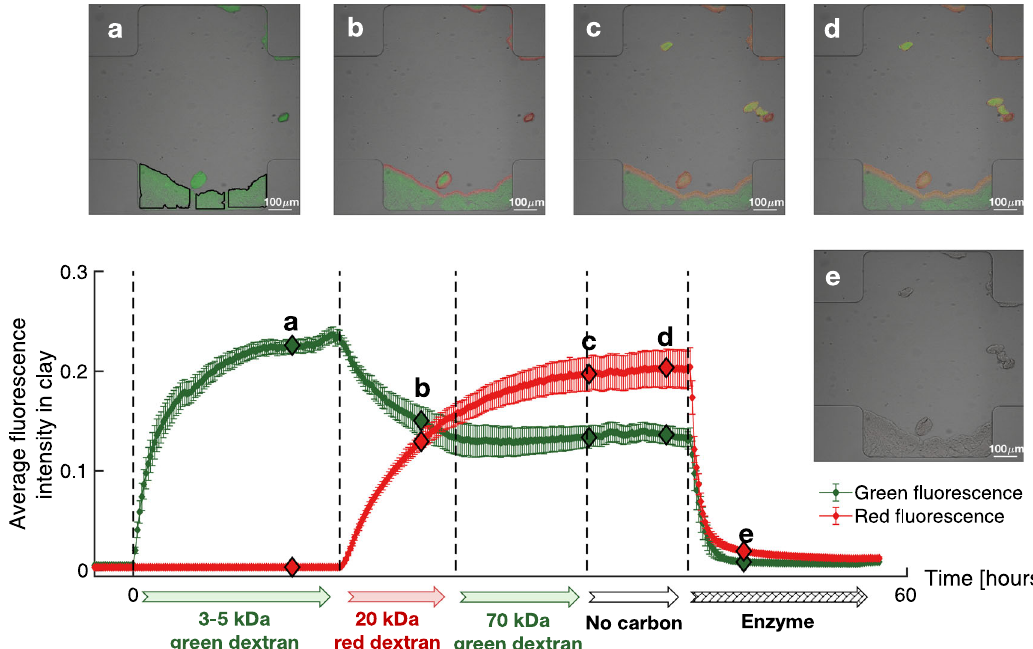
Fig. 3 Exoenzyme dextranase releases irreversibly sorbed high molecular-weight carbon. Cross-sectional fl uorescence images of a micro fl uidic channel designed to mimic a soil macropore (typical pore size >50 – 100 μ m) containing clay micro-aggregates, taken at times a – e (diamond symbols along the intensity curves), super-imposed on bright- fi eld images. The three black contours in panel a show the three immobile clay regions used to calculate the mean and the standard errors of the average fl uorescence intensity in clay. Background buffer solutions variably enriched with organic substances were injected sequentially into the channel: (1) 0.05 g/L green 3 – 5 kDa dextran, (2) 0.05 g/L red 20 kDa dextran, (3) 0.05 g/L green 70 kDa dextran, (4) no organics, and (5) 2 g/L enzyme (dextranase). The symbols and error bars represent the means and the standard errors of the average fl uorescence intensity within the three immobile clay regions (outlined by three black contours in Fig. 3a). Note that during the experiment, three clay aggregates appeared in the fi eld of view from the upstream of the channel (compare panels b and c ). This is because when we switched the valve to change the injection to a different fl ow/solution, small vibrations of the in fl ow tubes mobilized the clay aggregates. Such temporal disturbances do not affect the result because only the intensity in the immobile clay regions was considered. The start time and duration of each injection are indicated, respectively, by the vertical dashed lines and the arrows underneath the horizontal time